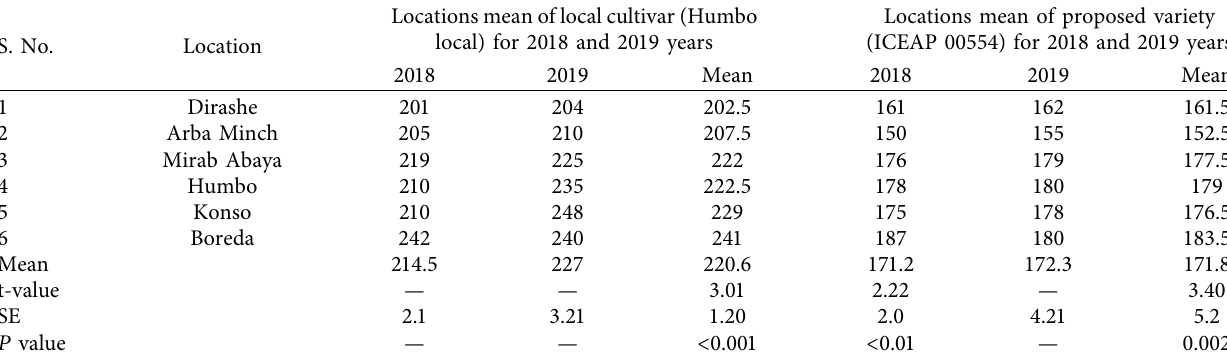
Table 6: Days to 90% maturity of pigeon pea genotypes across locations during the 2018 and 2019 cropping seasons, South Ethiopia. S.